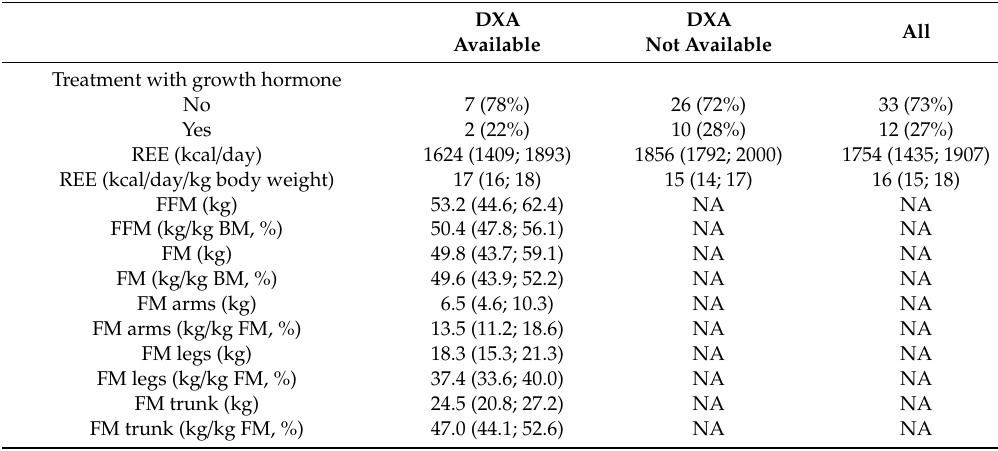
Table 1. Cont . DXA